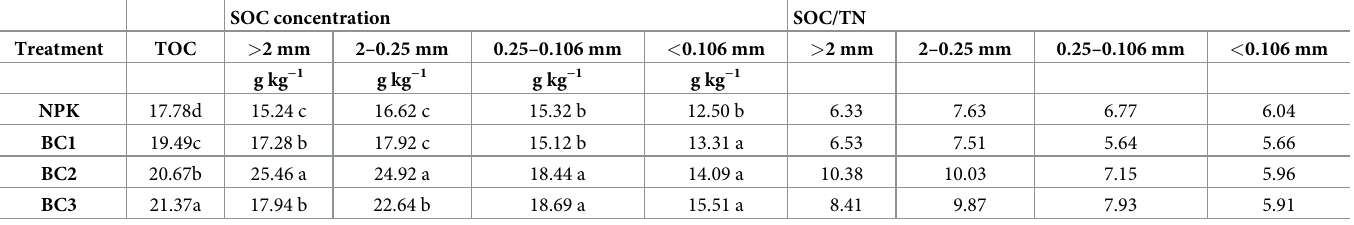
Table 5. Total organic carbon in soil aggregates for the addition of different amounts of biochar. SOC concentration SOC/TN Treatment